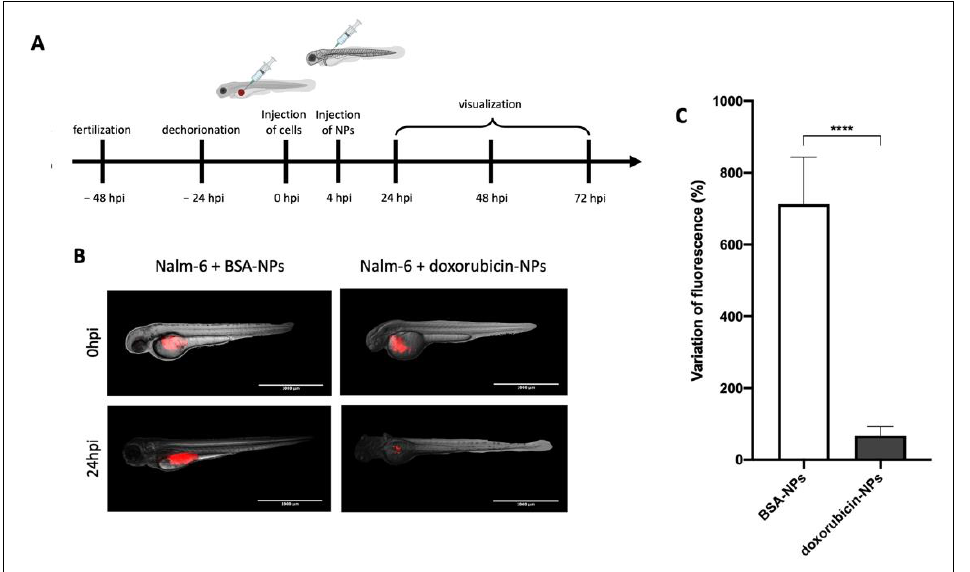
Figure 6. Evaluation of the therapeutic effect of doxorubicin-NPs: ( A ) Timeline of the experimental procedure. ( B ) Nalm-6 cells (labeled with red-fluorescent Calcein-AM) were injected into the periv- itelline space of zebrafish embryos 48 hpf, and 4 h later, BSA-NPs (left panels) or doxorubicin-NPs (right panels) were injected in the duct of Cuvier. Zebrafish were analyzed immediately after the injection of NPs (upper panels) and 24 hpi (lower panels). Magnification 40×. Scale bar 1000 μ m. ( C ) Data analysis of the variation of cells’ fluorescence after treatment with NPs expressed as a percent- age of untreated animals. All data are reported as the mean ± SD. p ≤ 0.0001 = ** **.